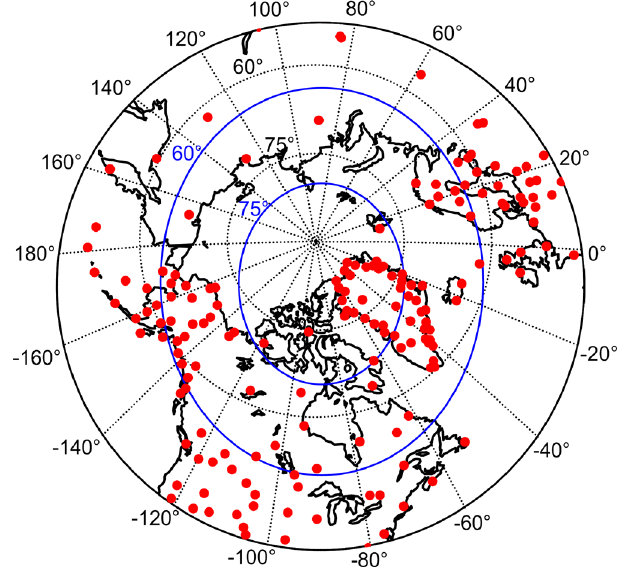
Fig. 4. Distribution of GNSS permanent stations employed in experiment. The altitude-adjusted corrected geomagnetic latitudes (blue lines) are superposed over the geographic grid.